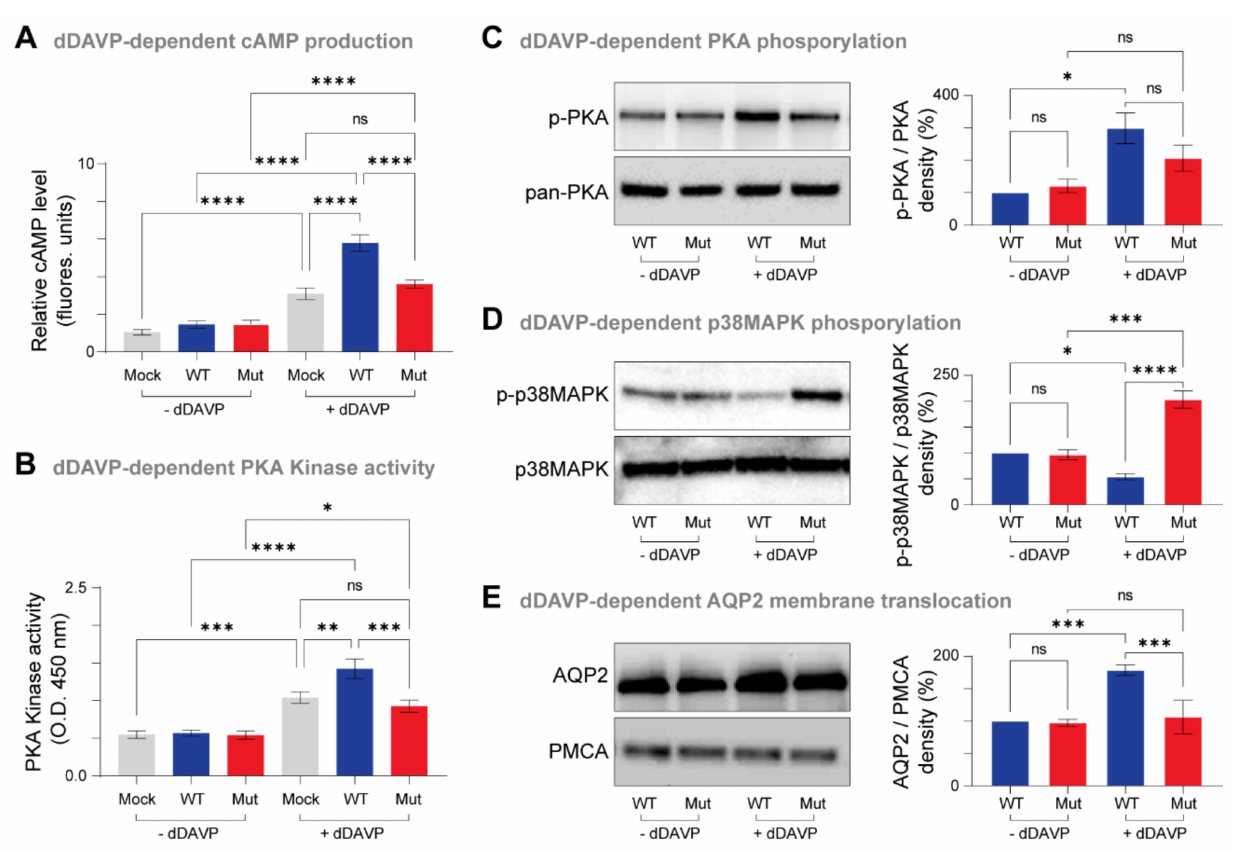
Figure 4. Ala165Pro-AVPR2 mutant impairs the activation of AVP-dependent downstream signaling pathways. ( A , B ) HEK293 cells were transiently transfected with WT-AVPR2 (WT) or Ala165Pro-AVPR2 (Mut). After 36 h, the cells were stimulated with dimethyl sulfoxide (DMSO) control ( − dDAVP) or 1 µ M dDAVP (+dDAVP) for 10 min and processed for quantification of intracellular cAMP (A) and PKA kinase activity. ( B ) The Mut AVPR2 displays lower cAMP and PKA activation levels than the WT. ( C , D ) WT and Mut AVPR2 expressing cells were stimulated with DMSO control ( − dDAVP) or 250 nM dDAVP (+dDAVP) for 60 min. Cells were then harvested, lysed and proteins were analyzed by immunoblotting using antibodies against total and phosphorylated (p-) PKA ( C ) and p38-MAPK ( D ) (left panels). Phosphorylated protein abundance was normalized against the respective total proteins and a semiquantitative analysis of the effects of Ala165Pro phosphorylation was done by densitometry (right panels). ( E ) WT and Mut AVPR2 expressing cells were stimulated with DMSO control ( − dDAVP) or 250 nM dDAVP (+dDAVP) for 60 min. Following the treatment, cells were biotinylated using Sulfo-NHS-SS-Biotin and then precipitated with streptavidin-Sepharose beads. Immunoblotting was performed with antibodies against AQP2 to visualize its surface expression (left panel). PMCA was used as a loading control. A semiquantitative analysis of the effects of Ala165Pro mutation on the plasma membrane levels of AVPR2 protein was done by densitometry (right panel). Values in all bar charts are given in means ± SEM ( n = 3). Asterisks indicate significant differences (one-way ANOVA; Tukey multiple comparisons correction): * p ≤ 0.05; ** p ≤ 0.01; *** p ≤ 0.001; **** p ≤ 0.001; ns, not